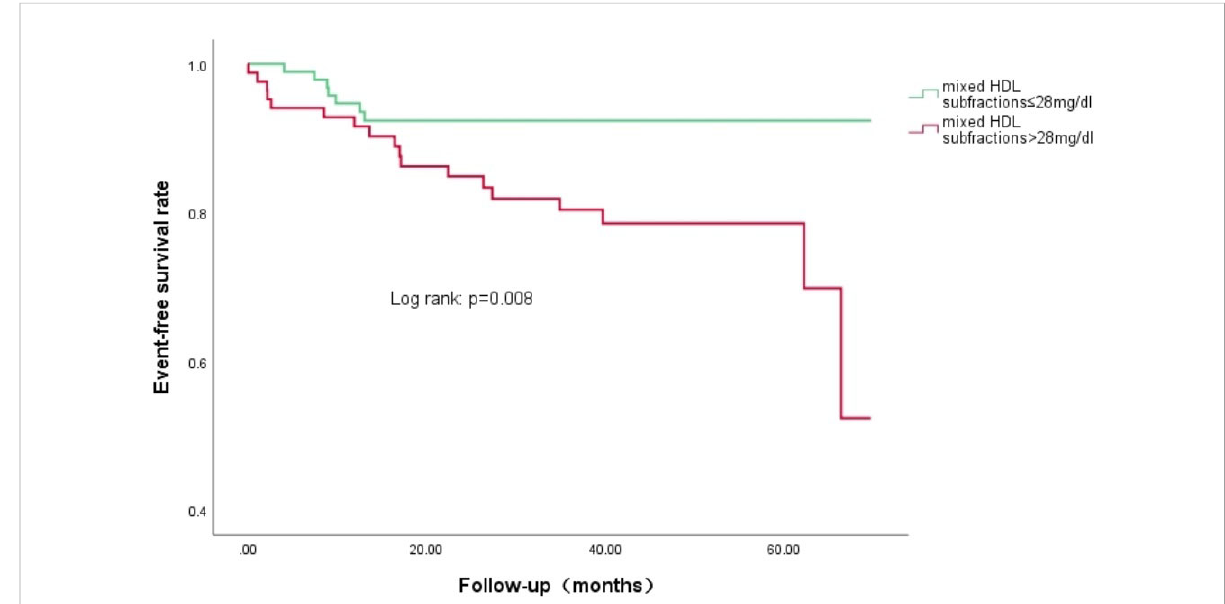
FIGURE 2 Kaplan-Meier curves of the cumulative event-free survival analyses according to mixed HDL subfractions levels in T2DM and SCAD patients at